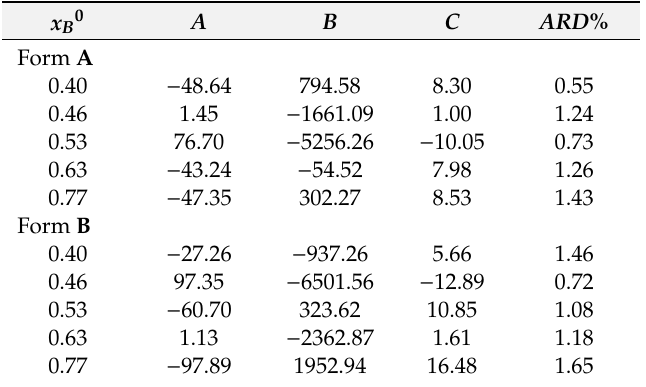
Table 3. Fitting parameters of modified Apelblat model for MTBE + toluene